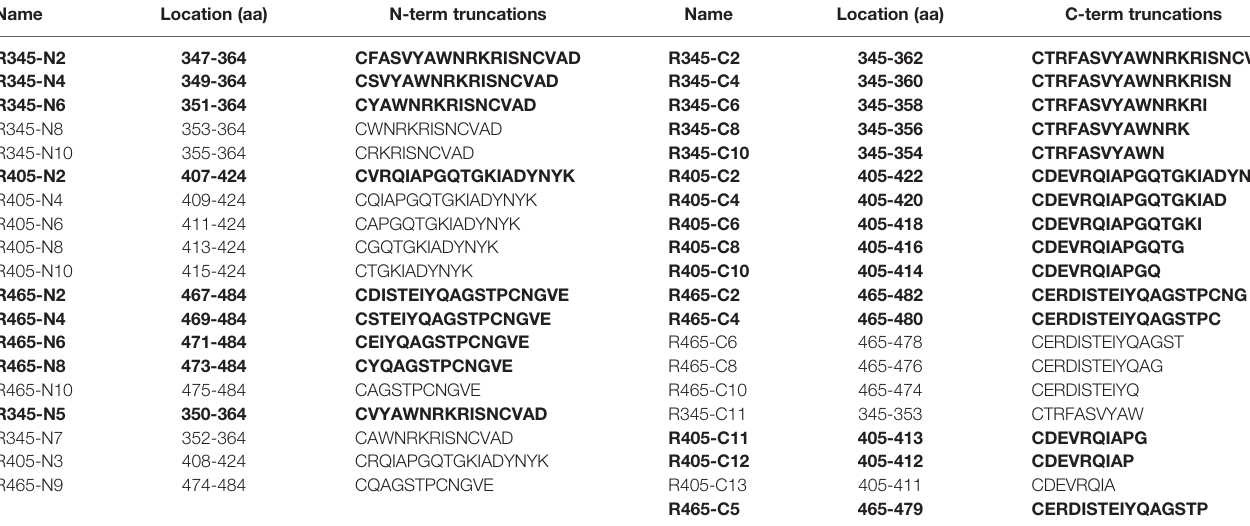
TABLE 4 | Truncation library of the identi fi ed epitope peptides used in this